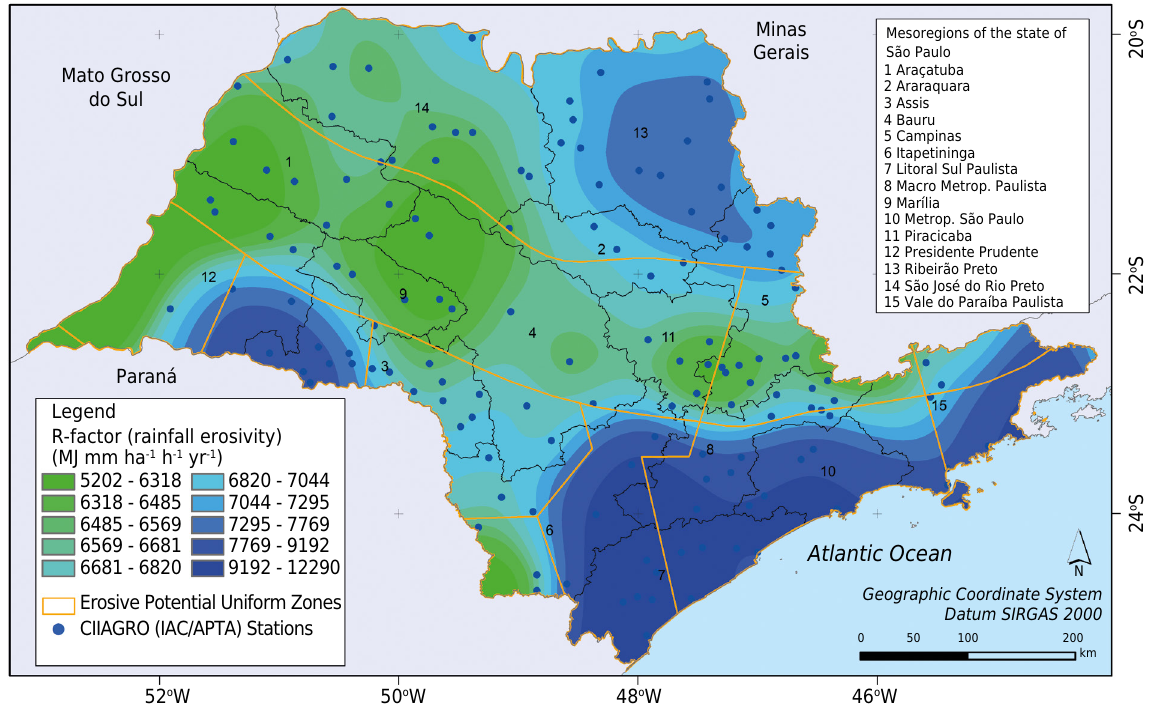
Figure 3. Rainfall erosivity map obtained by Medeiros